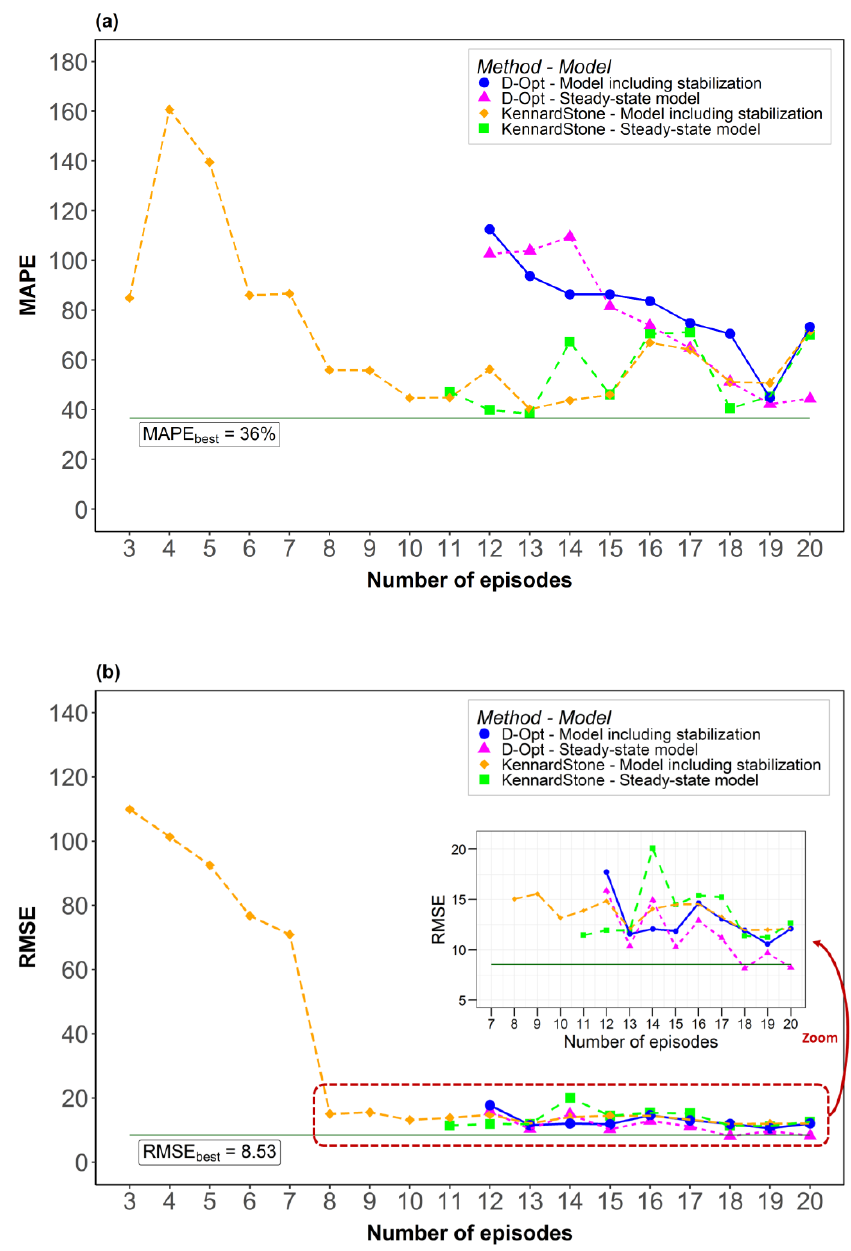
Figure 2. Indicator mean absolute percentage error (MAPE) ( a ) and root mean square error (RMSE) ( b ) on 38 steady-state points as a function of the number of episodes in the calibration dataset (the dark green horizontal solid line represents the indicator of the best scenario).